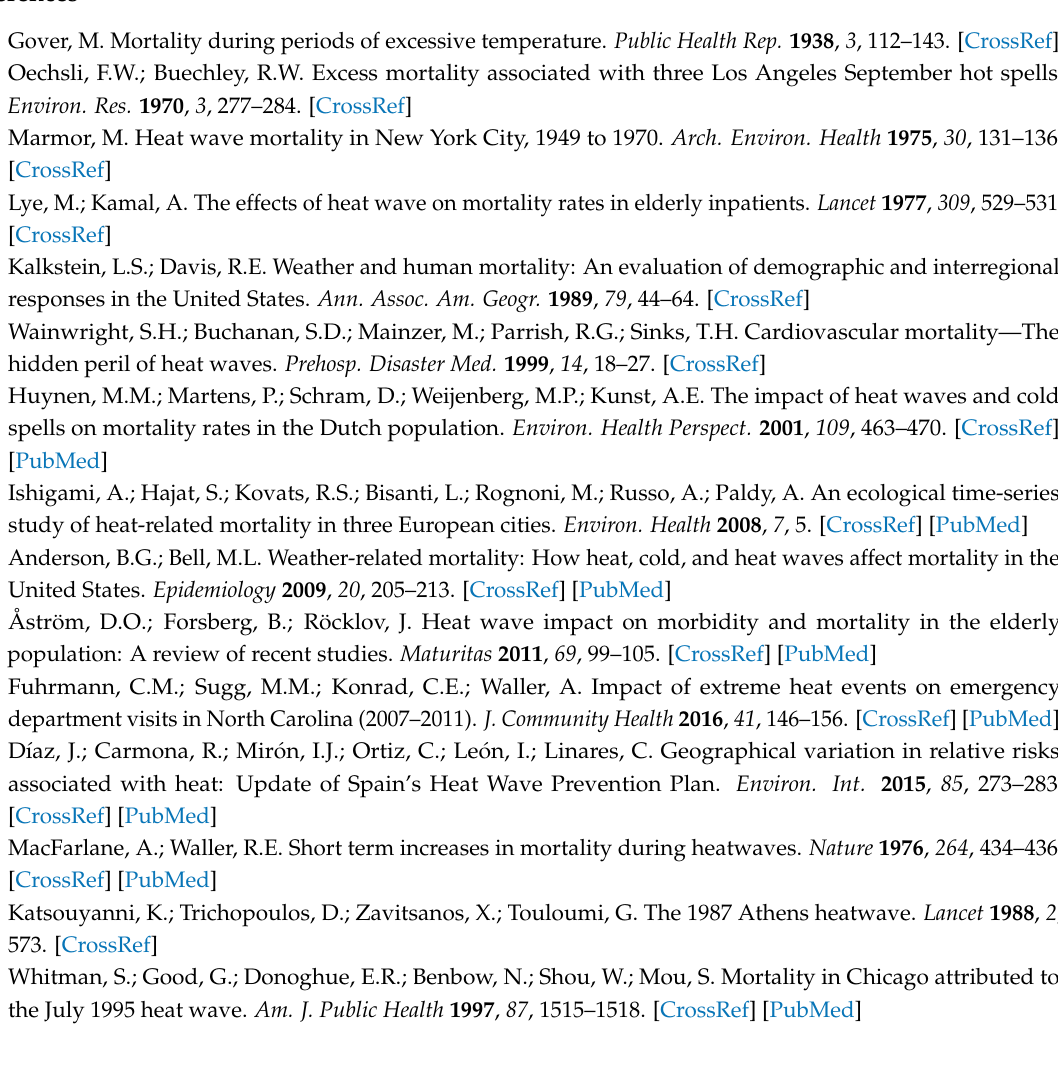
s1, Table S1: Pearson’s correlation coefficient between total admissions and admissions for the various categories over all days and during heat waves